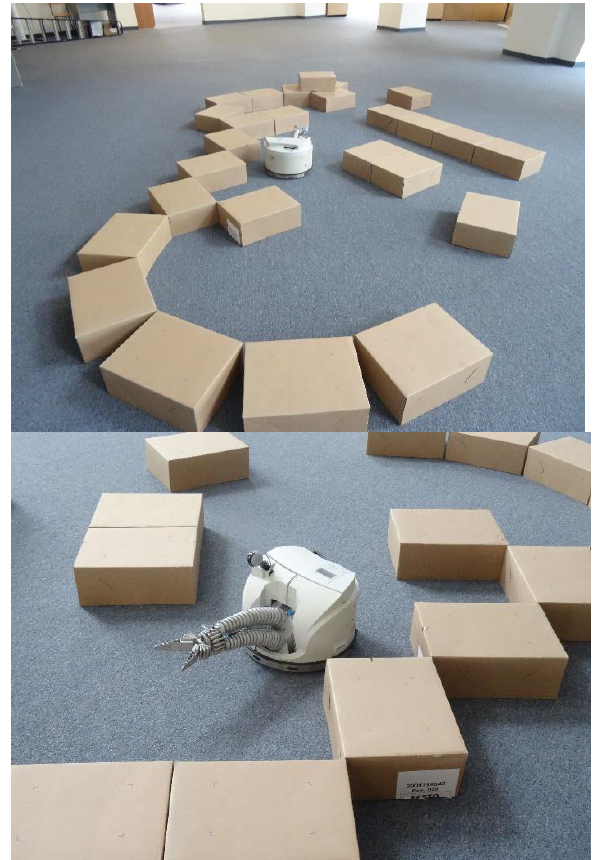
Figure 5. Motion of Robotino robot in